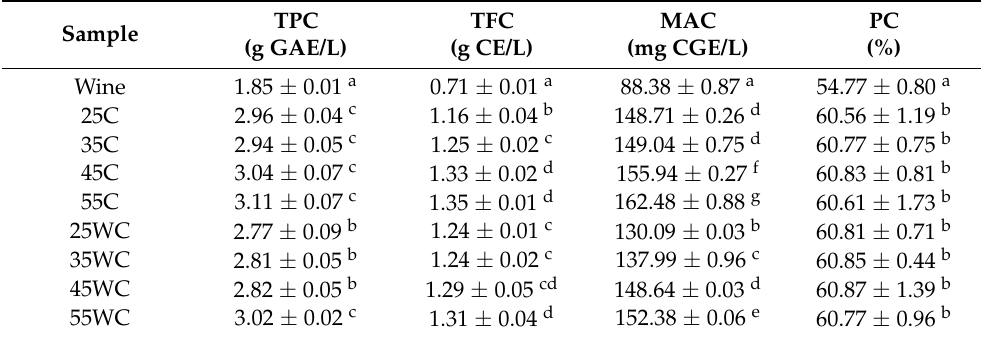
Table 3. Total phenolic compounds of the initial Cabernet Sauvignon wine variety and retentates obtained by nanofiltration at 25, 35, 45, and 55 bar with cooling (C) and without cooling